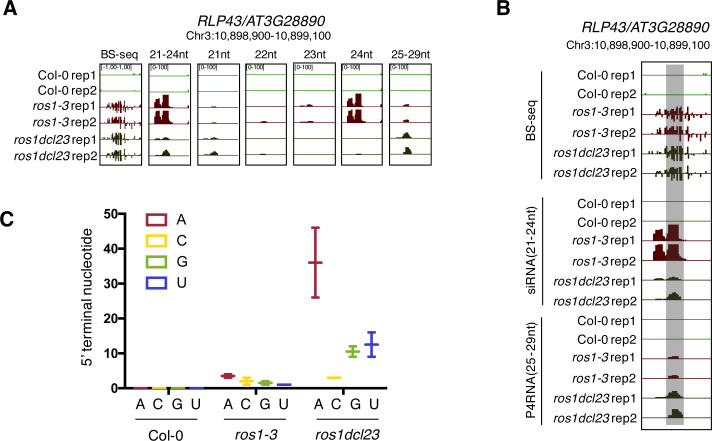
Gain of 21-nt siRNAs and P4RNAs at the RLP43 promoter in the ros1dcl23 background might contribute to the maintenance of DNA methylation levels in this triple mutant.(A) Snapshot representing levels of DNA methylation and siRNA species classified per size at the RLP43 promoter, in 5-week-old rosette leaves of untreated Col-0, ros1-3, and ros1dcl23. (B) Snapshot representing levels of DNA methylation, 21–24 nt siRNAs and 25–29 nt P4RNAs at the RLP43 promoter, in 5-week-old rosette leaves of untreated Col-0, ros1-3, and ros1dcl23. The region presenting increased P4RNAs is highlighted in the grey box. (C) Number of putative P4RNAs classified depending on the nucleotide present at the 5’ terminal in Col-0, ros1-3, and ros1dcl23. Data from the two biological replicates are presented.